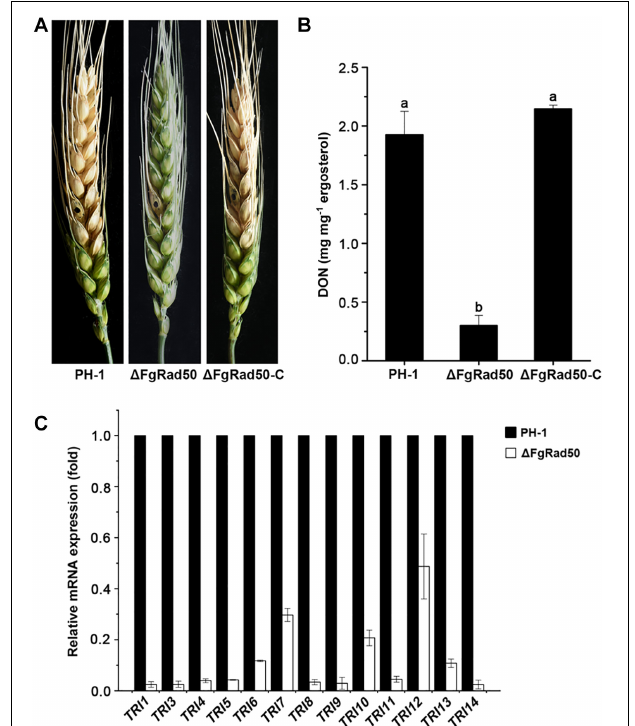
FIGURE 7 | Impact of FgRad50 deletion on virulence and DON biosynthesis in F. graminearum . (A) Disease symptoms on wheat heads caused by (cid:49) FgRad50 and (cid:49) FgRad50-C. Wheat heads were point-inoculated with a conidial suspension of each strain, and infected wheat heads were observed 15 days after inoculation. (B) Levels of DON produced by each strain in infected spikelets collected from inoculated wheat heads. Error bars denote standard errors of three replicate experiments. Means of bars followed by the same letter are not significantly different at p = 0.05. (C) Relative transcription levels of 13 TRI genes in WT PH-1 and (cid:49) FgRad50. For each gene, the expression level in PH-1 was arbitrarily set as 1. Bars denote standard errors from three repeated experiments.